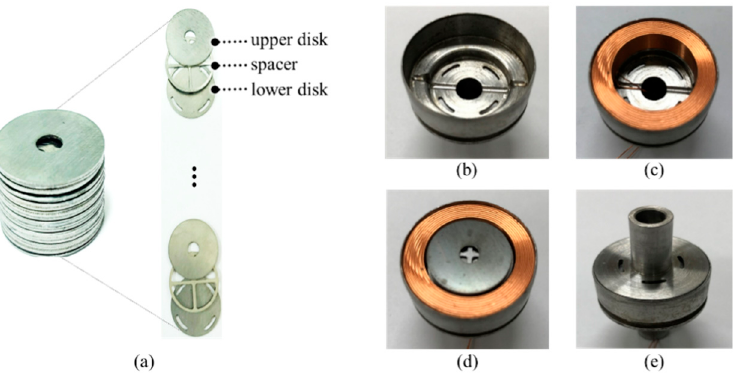
Figure 9. Fabrication process of the movable piston: ( a ) The layered disk where three patterns are repeated; ( b ) Shell; ( c ) Solenoid coil fitted in the shell; ( d ) Layered disk inserted into the shell; ( e ) Fabricated movable piston.